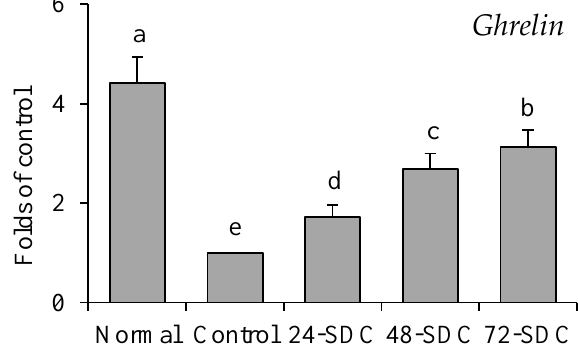
Figure 8. Messenger RNA level of ghrelin in gastric tissue of mice. Values presented are means ± standard deviation ( n = 3). Different letters indicate significant differences ( p < 0.05) between each group, and the same letters indicate that there is no significant difference ( p > 0.05) between each group according to Tukey’s test for multiple comparisons. 24-SDC: 24-h-fermented Shuidouchi; 48-SDC: 48-h-fermented Shuidouchi; 72-SDC: 72-h-fermented Shuidouchi.